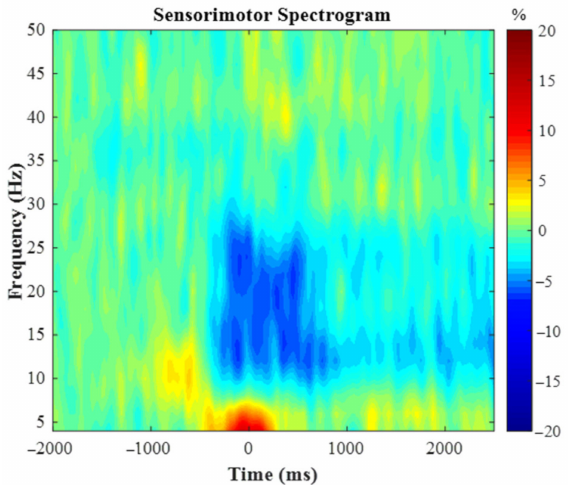
Figure 2. Group-averaged time frequency spectrogram from a sensor located over the leg region